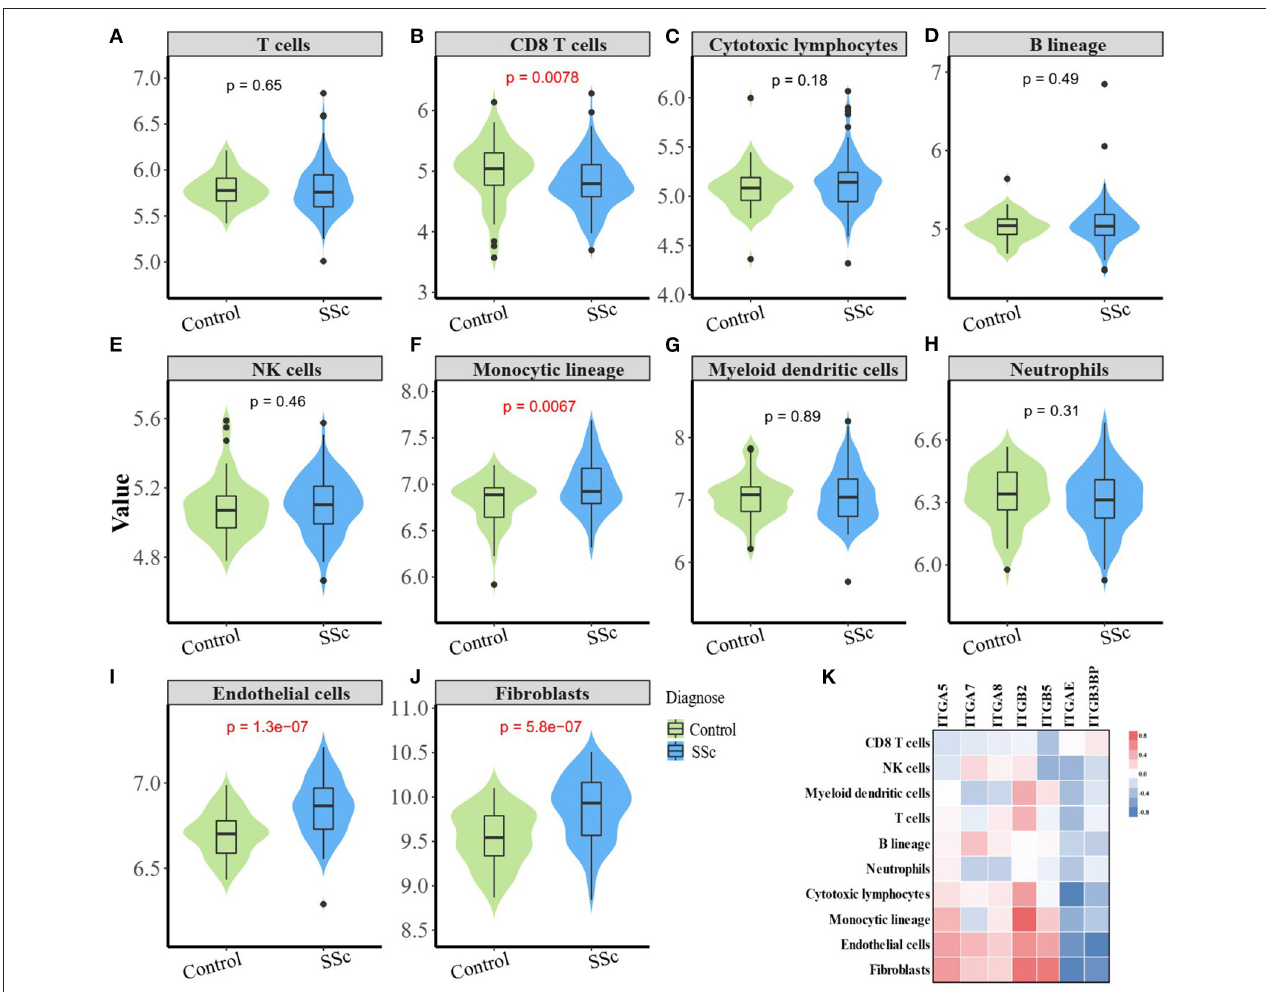
FIGURE 4 | Correlation between aberrant expressed integrin family gene and the infiltration of immune and stromal cells in the skin of SSc. (B) The abundance of CD8 + T cell is relatively low in the skin from SSc patients than healthy controls. (F, I, J) The abundance of monocytic lineage, endothelial, and fibroblast were higher in SSc patients compared with healthy control, respectively. (A, C–E, G, H) The abundance of total T cells, cytotoxic lymphocytes, B cells, NK cells, myeloid dendritic cells, and neutrophils showed no difference between SSc patients and healthy control. (K) The mRNA expression level of ITGA5 was positively correlated with fibroblasts ( r = 0.47, p < 0.0001), endothelial cells ( r = 0.44, p < 0.0001), and monocytes ( r = 0.35, p < 0.0001). The mRNA expression level of ITGB2 was significantly higher than that of fibroblasts ( r = 0.64, p < 0.0001), endothelial cells ( r = 0.52, p < 0.0001), T cells ( r = 0.36, p < 0.0001), and myeloid dendritic cells ( r = 0.39, p < 0.0001). The mRNA expression level of ITGB5 was positively correlated with fibroblasts ( r = 0.63, p < 0.0001), endothelial cells ( r = 0.43, p < 0.0001), and monocytes ( r = 0.26, p = 0.0021). SSc, systemic